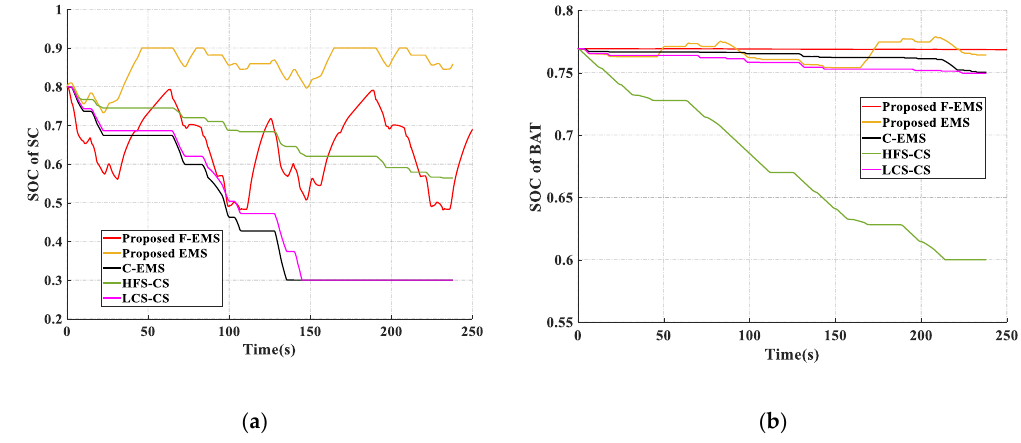
Figure 15. State of charge of ( a ) SC– SoC SC , and ( b ) BAT– SoC BAT .